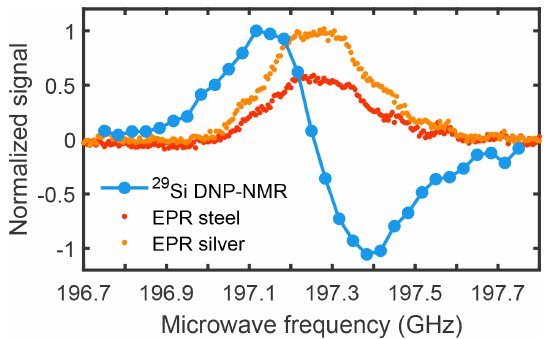
Figure 6. LOD-EPR spectra of silicon particles (AA1-20µm), with microwave power according to the steel waveguide (red) and silver- plated waveguide (orange) at 20K. The corresponding 29 Si DNP profile (blue) is measured at 3.4K with a buildup time of 300s to obtain sufficient